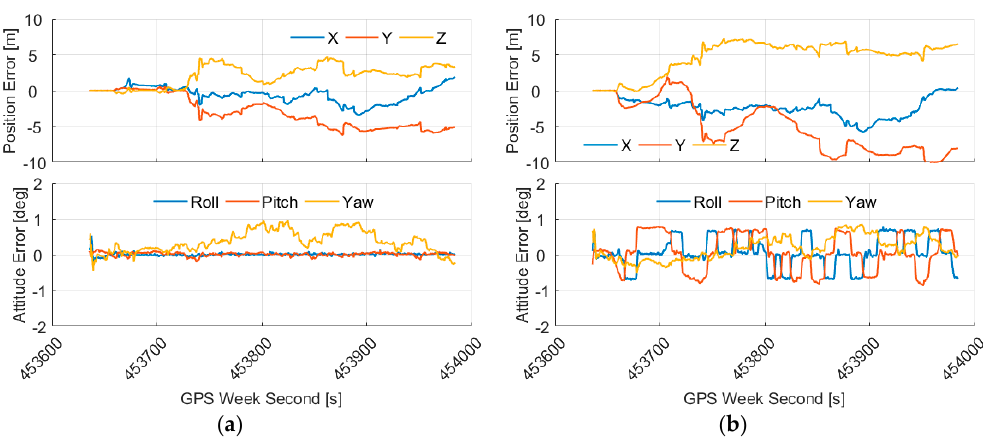
Figure 7. The RMSEs of the MTi-G-710 under 0-degree geodetic displacement for the sequence WRIC: ( a ) The RMSEs for Setting A, and ( b ) the RMSEs for Setting C.